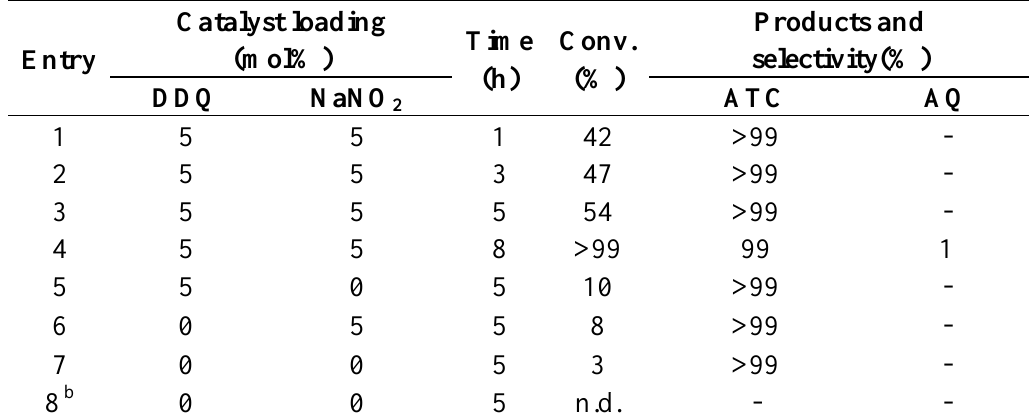
Table 2 . Effect of reaction time on the catalytic oxidative dehydrogenation of 9,10- dihydroanthracene to anthracene a